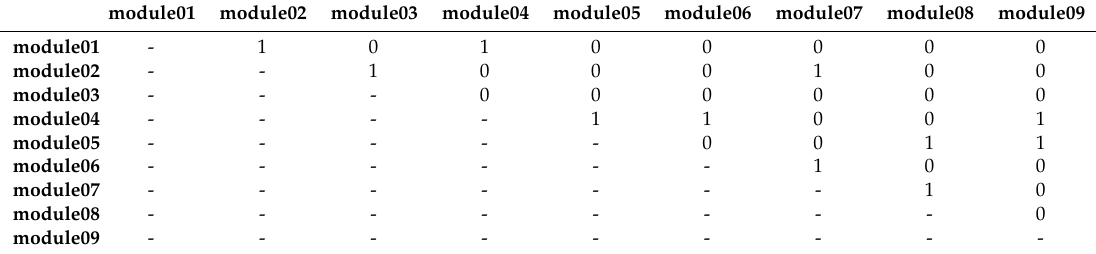
Table 1. Directional adjacency matrix for the left panel in Figure 1. Modules are ordered according to time (top to bottom in the left panel of Figure 1). Rows indicate the source module; columns indicate the target